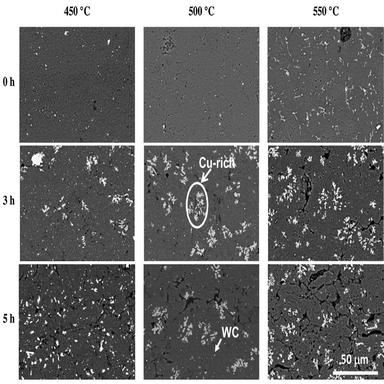
SEM-BSE images obtained from Al-Cu-Mg/WC composites after 0, 3, and 5 h of milling and sintering at 450, 500, and 550 °C.